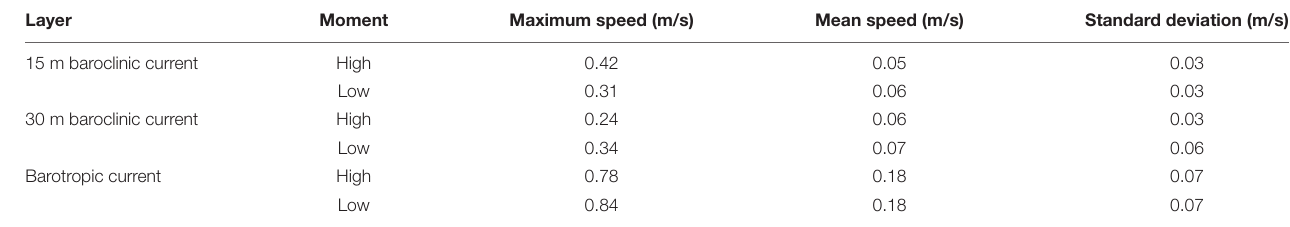
TABLE 2 | Statistics of current speed around the Changshan islands in Figure 8